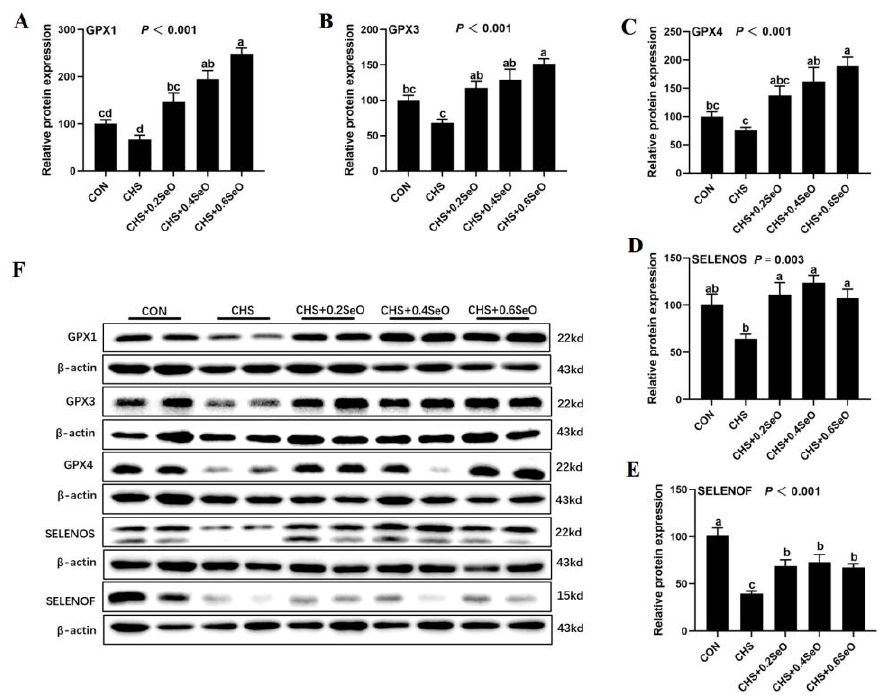
Figure 8. Effects of CHS and SeO supplementation on the protein expression abundance of GPX1, GPX3, GPX4, SELENOS and SELENOF in the spleen. ( A – E ) Relative protein expression level, ( F ) Relevant protein bands.The results were expressed as mean ± SEM ( n = 6). Different letters (a, b and c) denote significant differences ( p < 0.05).